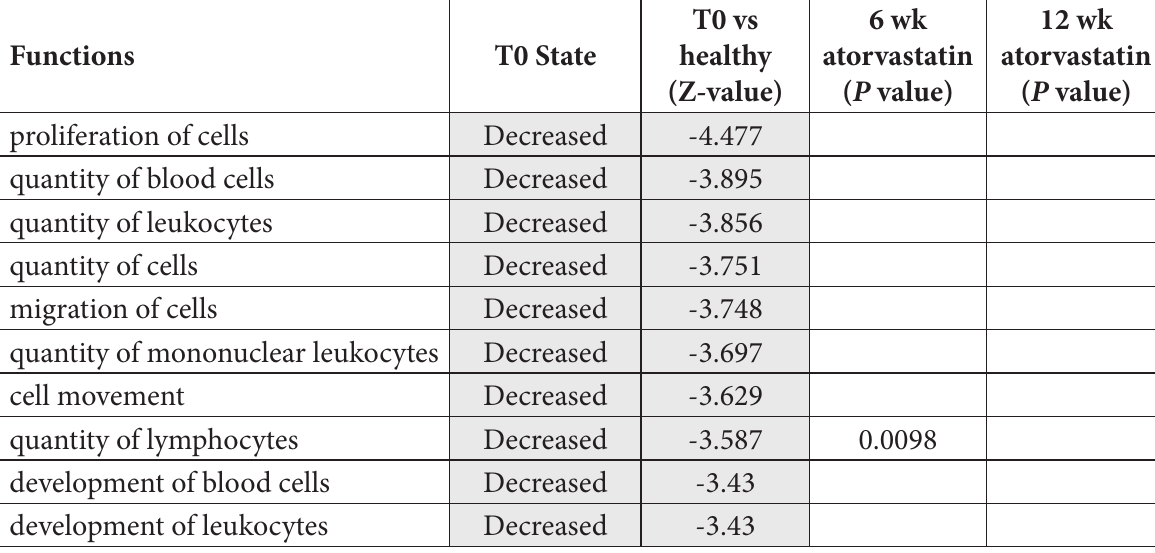
Table 7. Effect of atorvastatin on gene pathways that were significantly altered in HIV/ART compared to HIV-negative individuals at